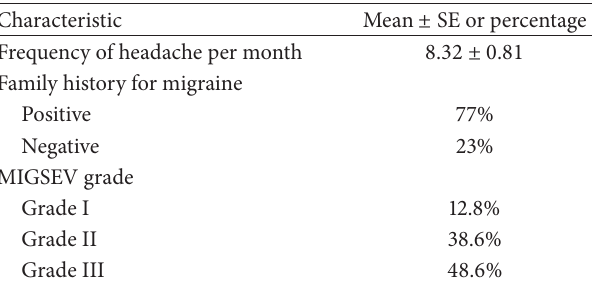
Table 1: Demographic and clinical characteristics of patients with